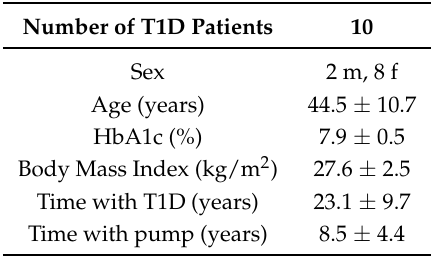
Table 1. Demographic characteristics for the dataset